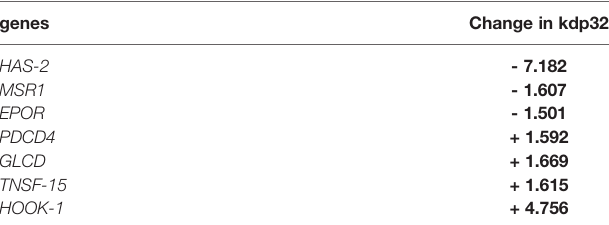
TABLE 2 | Genes associated with the malignant phenotype that changed their expression in RKO knock down p32 cells.